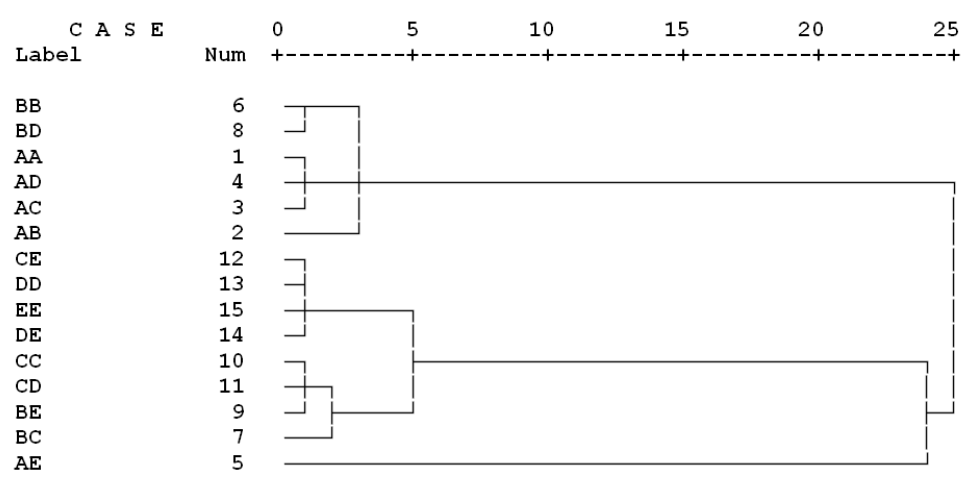
Figure 14. Cluster analysis based on the thermal transmittance coefficients and the outdoor temperatures (the 15 treatments clustered to each other are defined in Tables 4 and 5).